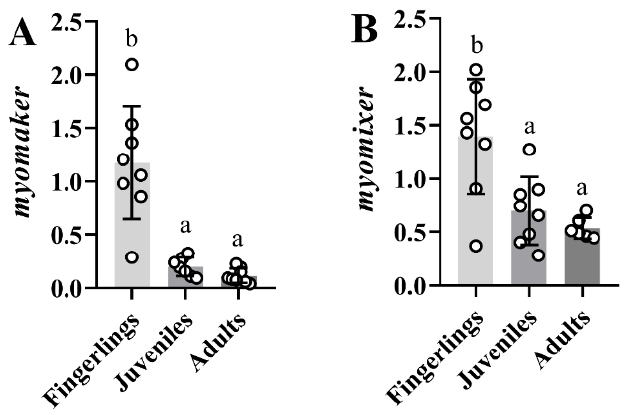
Figure 10. Bar plots of relative gene expression of myomaker ( A ) and myomixer ( B ) in white skeletal muscle of three different sizes of gilthead sea bream. White-filled circles represent individual relative gene expression values. Data are presented as means ± SEM ( n = 6). Different letters indicate significant differences ( p < 0.05).